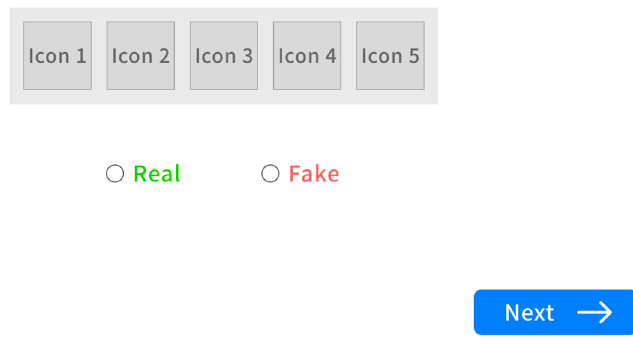
Figure 8. A sample of